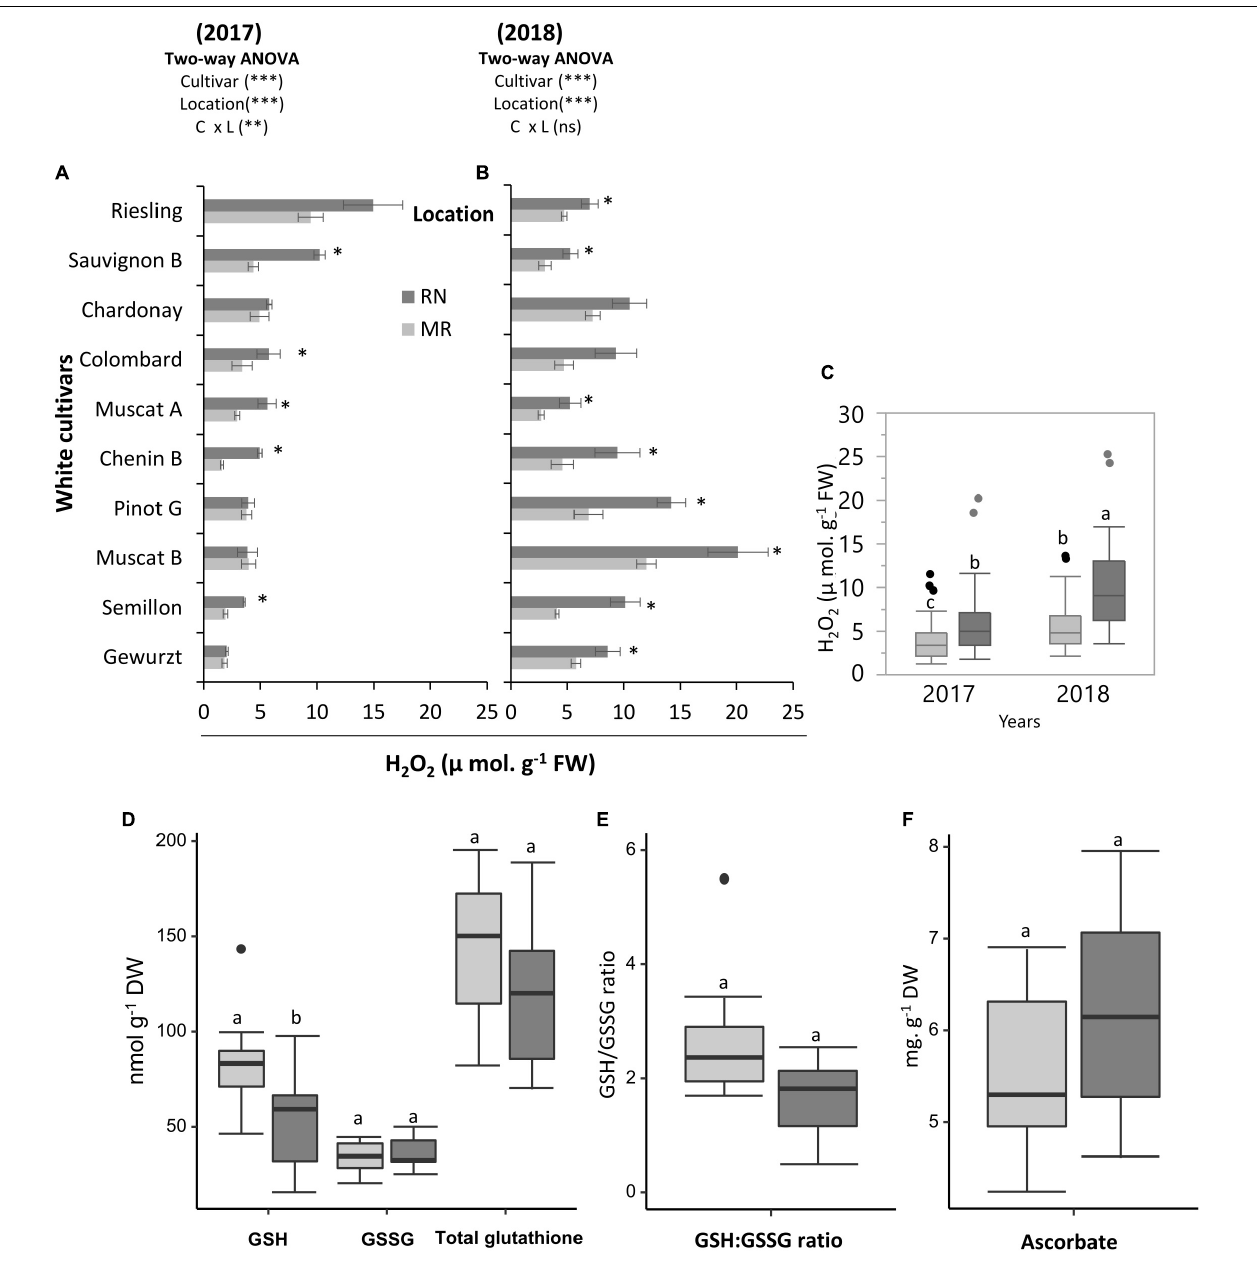
FIGURE 6 | Cultivar and environmental effect on H 2 O 2 and major redox buffers in ripe white berries. H 2 O 2 content measured on ripe white berries grown at the Mitzpe Ramon (MR) and Ramat Negev (RN) vineyards in 2017 (A) and 2018 (B) . Error bars are standard error ( n = 4). Bar plots followed by ∗ indicate significant differences between locations ( P < 0.05) within the same cultivar based on a non-parametric t -test. ∗∗ P < 0.01, ∗∗∗ P < 0.001 indicates Significant effects of the main factors in each season based on a two-way ANOVA. The box plot (C) shows the difference in the mean H 2 O 2 content of all cultivars ( n = 4 replicates × 10 cultivars) between locations in the 2017 and 2018 seasons. (D) The differences in the mean glutathione content and GSH to GSSG ratio (E) of all cultivars ( n = bulked replicate × 10 cultivars) between locations in the 2018 season. (F) The differences in the mean ascorbic acid content of all cultivars ( n = bulked replicate × 10 cultivars) between locations in the 2018 season. Different lowercase letters in box plots indicate significant differences in cultivar means between locations. Gray and black colors indicate cultivars grown at Mitzpe Ramon and Ramat Negev,